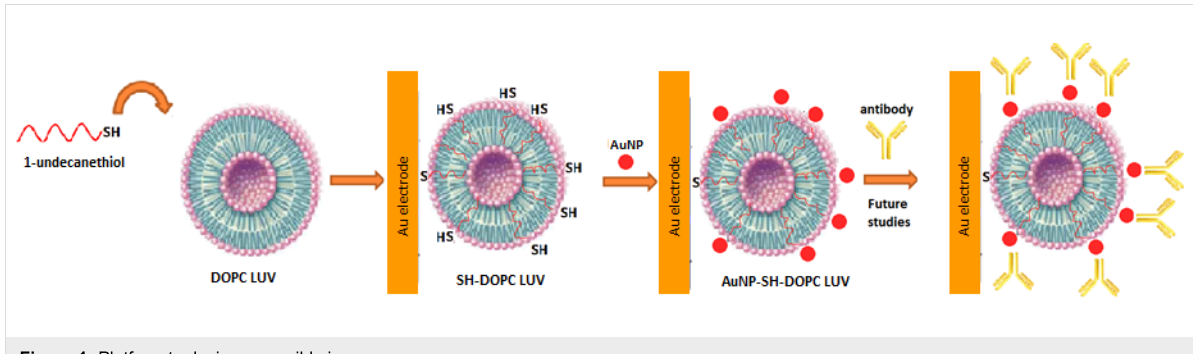
Figure 1: Platform to design a possible